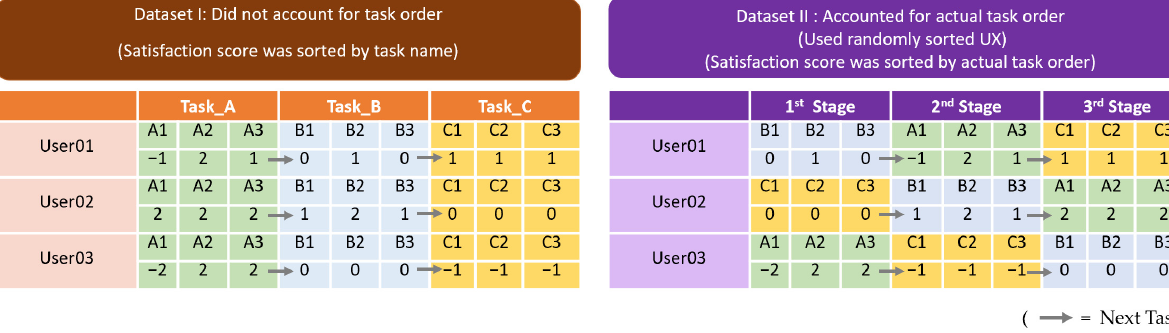
Figure 12. Two datasets created based on task order.